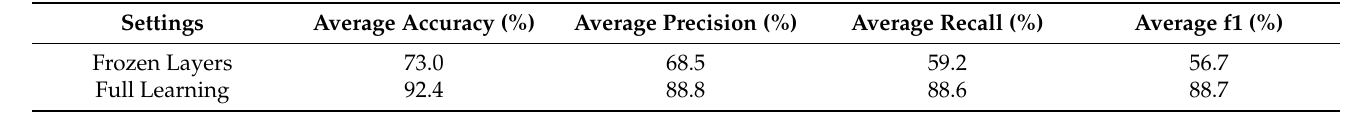
Table 2. Effect of freezing layers on the accuracy of the neural